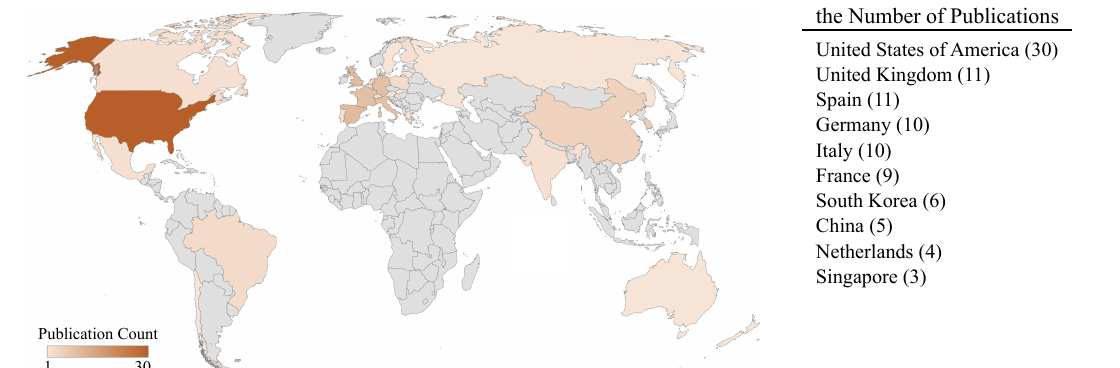
Figure 7. Number of publications proposing new methods of XAI from different countries of the world and the top 10 countries based on the publication count shown in parentheses, which is approximately 72% of the 137 articles selected for this SLR. The countries were determined from the affiliations of the first authors of the